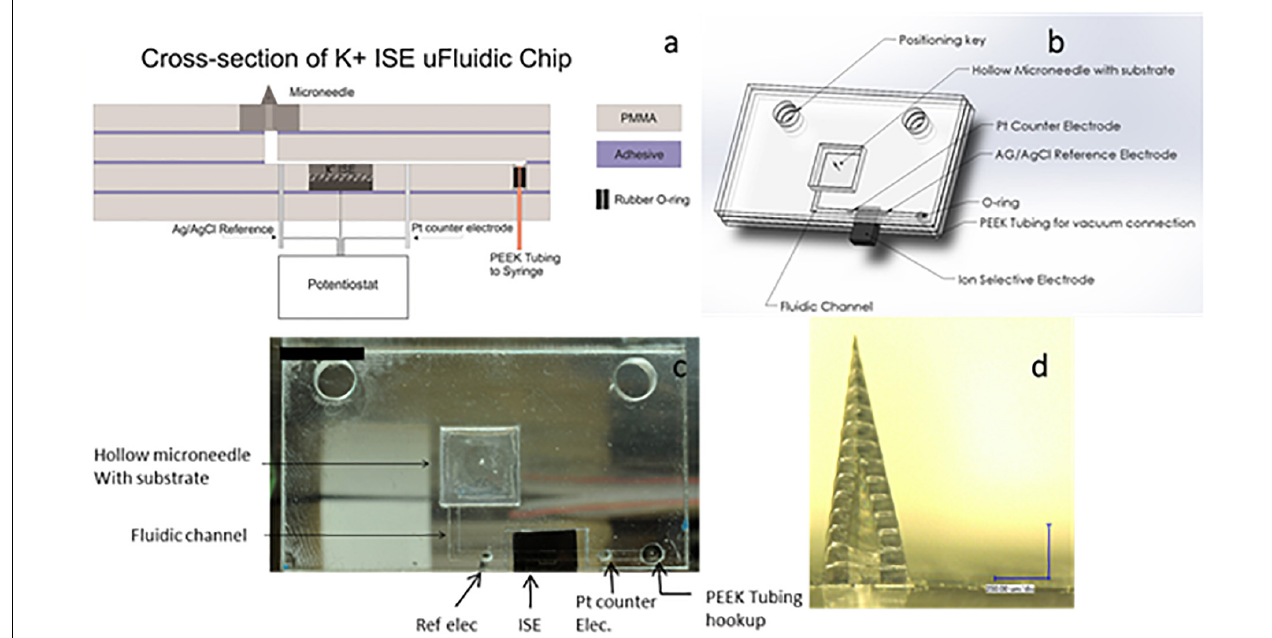
FIGURE 4 | (a) CorelDraw rendering of a cross-section of the K + ion-sensitive electrode microfluidic chip. (b) Solidworks drawing of the K + ion-sensitive electrode microfluidic chip. (c) Image of the microfluidic chip with on chip reference and counter electrodes. (d) Optical image of a single hollow microneedle made with two-photon lithography (two-photon polymerization) (scale bar = 250 µ m). Reprinted with permission from Miller et al. (2014).